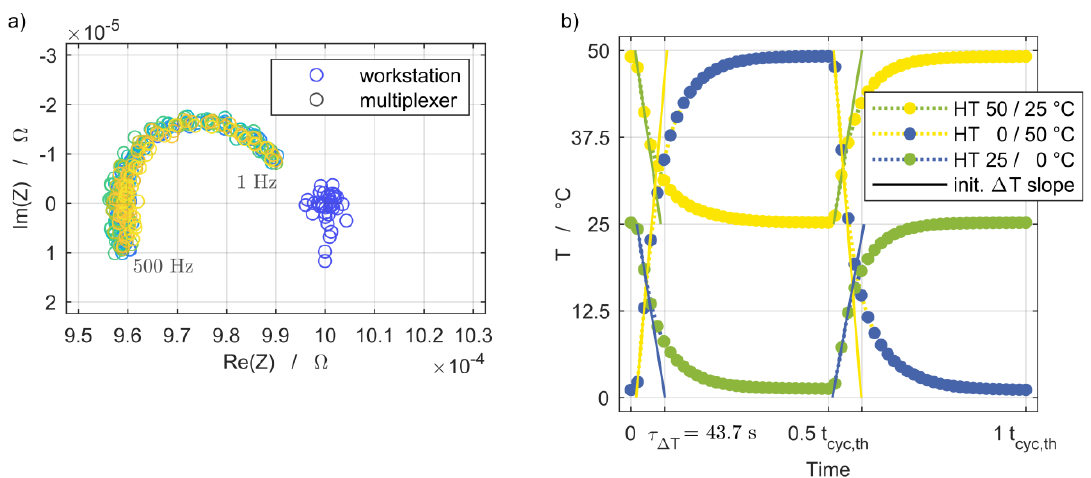
Figure 3. ( a ) Test measurements of the electrochemical workstation and multiplexer with a 1 mΩ reference resistor using the wiring employed for the cell characterization. Excitation of 1 A amplitude and frequency sweep between 1 Hz and 500 Hz. ( b ) Preliminary thermal cycling test snippet of simultaneous temperature changes of the homogeneous transient (HT) setups.